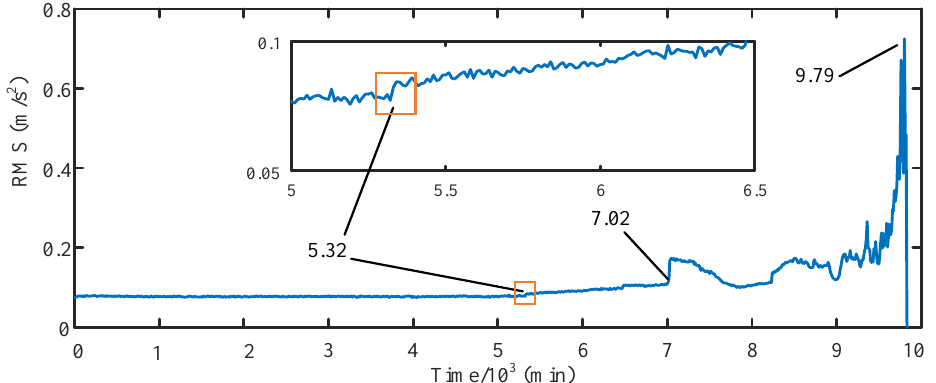
Figure 10. The RMS trend of bearing vibration signal in Case